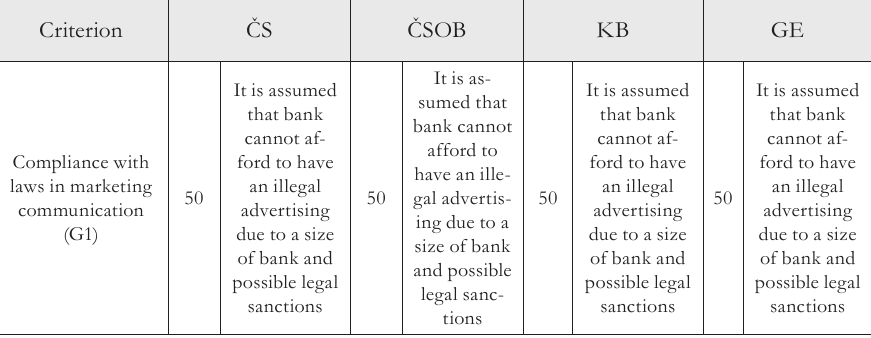
Tab 7 - Evaluation criteria in the area of the Consumer protection. Source: